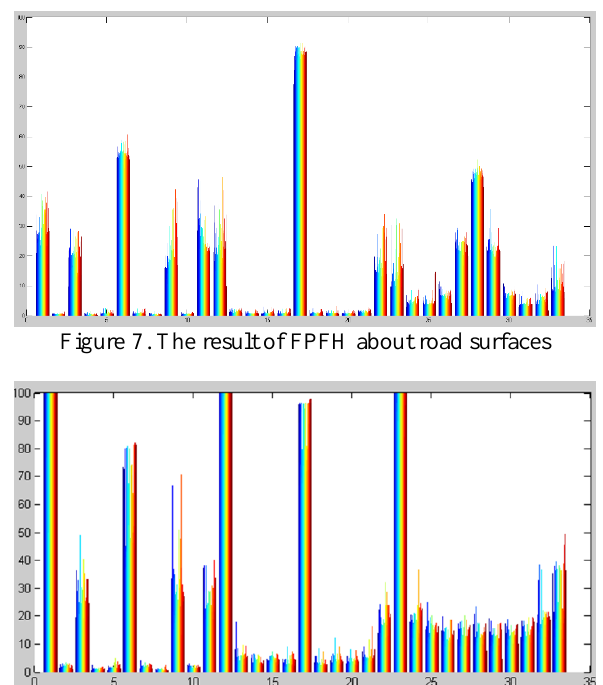
Figure 8. The result of FPFH about trees in the